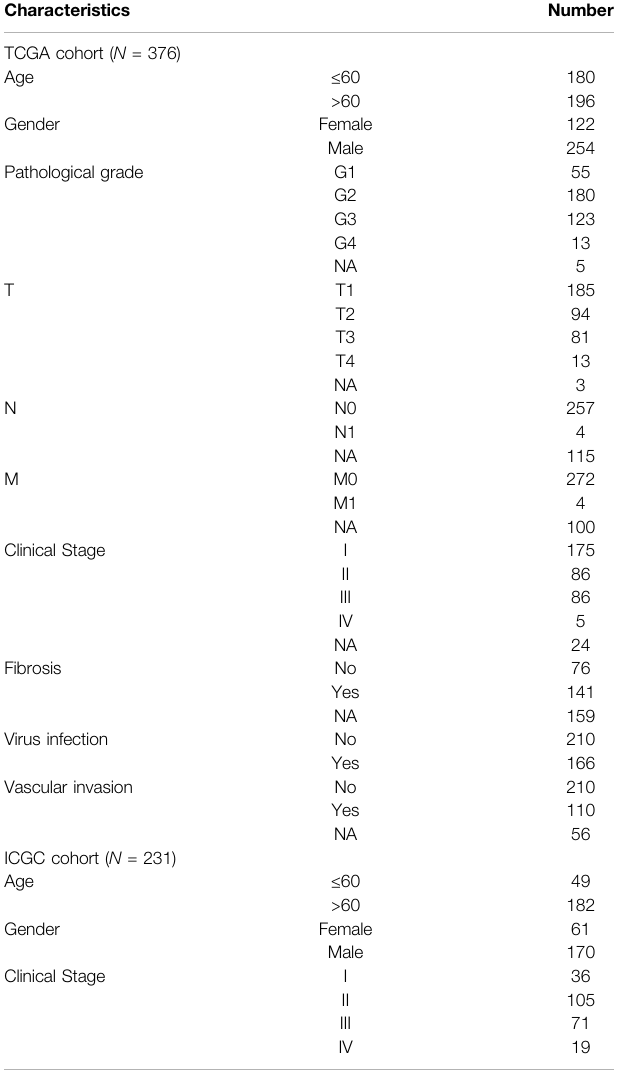
TABLE 1 | Clinical and pathological characters of HCC patients in TCGA and ICGC cohort.